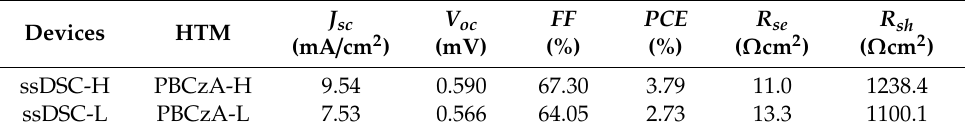
Table 2. Performance comparison of ssDSCs showing the highest PCEs.